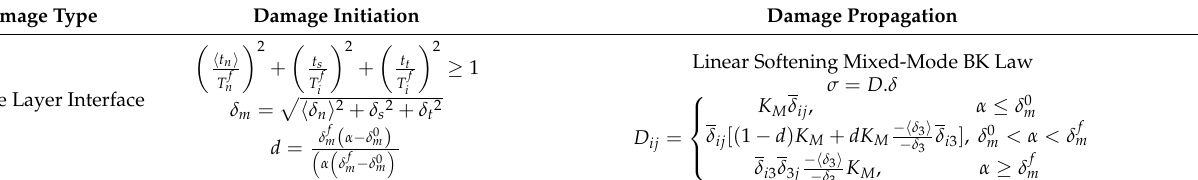
Table 3. Damage criterion for cohesive interface [31,32].